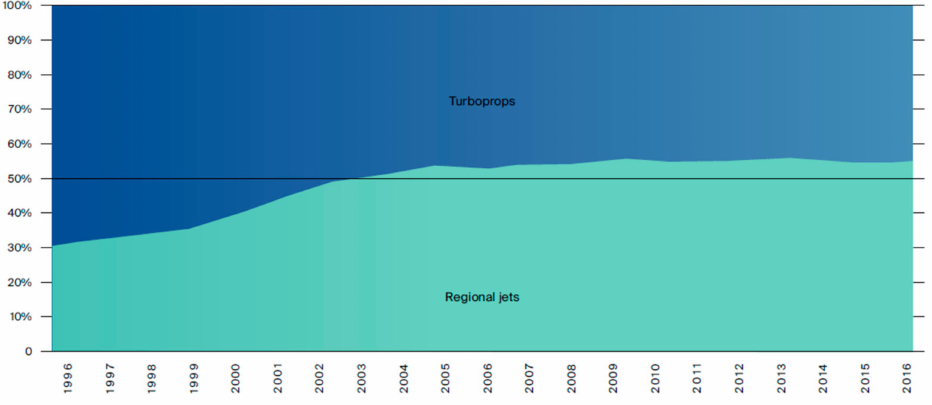
Figure 2. In-service fleet share of turboprops and regional jets. Reprinted from ref.